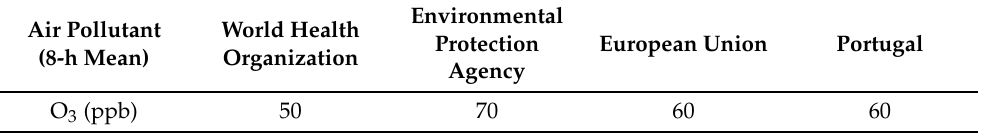
Table 1. Pollutant